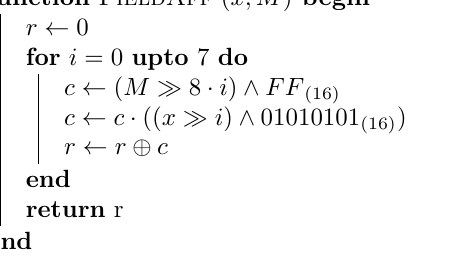
affine transform 2 8